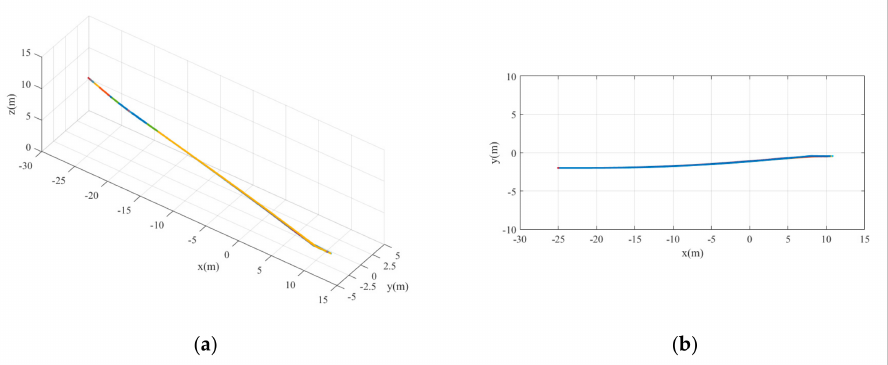
Figure 14. The landing trajectories under case 2. ( a ) 3D trajectory. ( b ) 2D trajectory in the x - y plane.